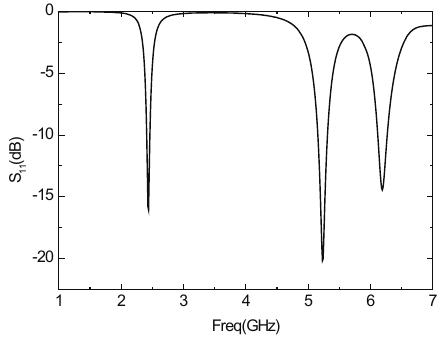
Figure 19. S 11 parameter curve of the antenna with a stepped groove.